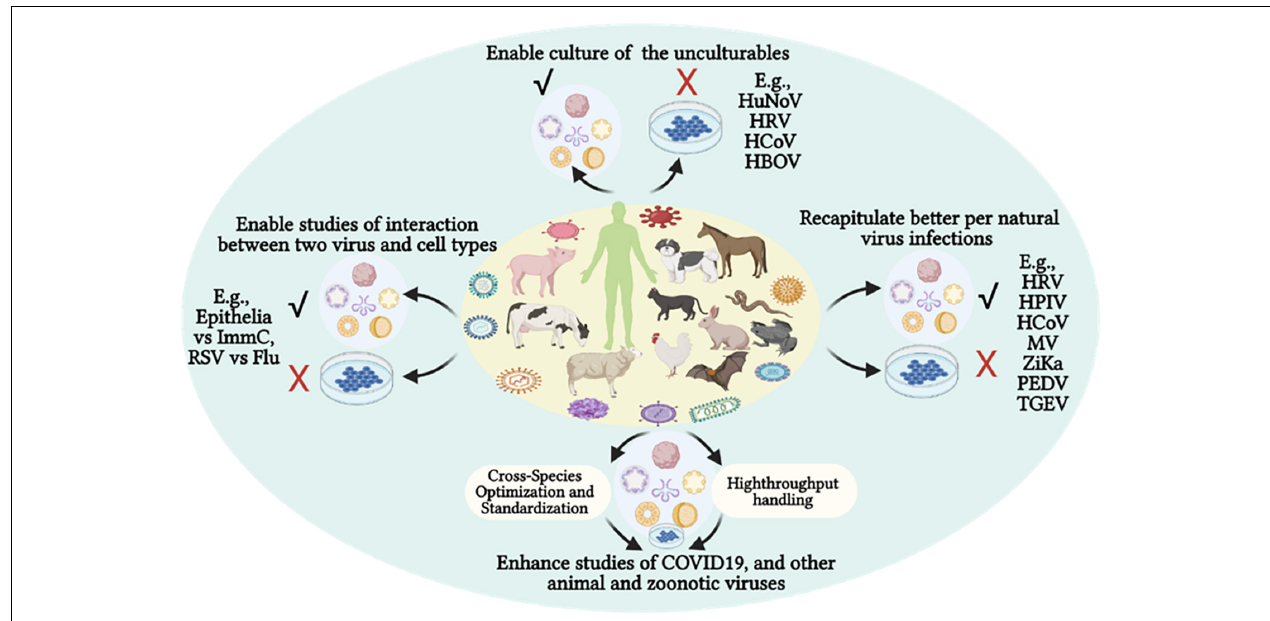
FIGURE 3 | Organoid culture potentiates virological studies, providing a better system to enable recapitulating of the natural viral infections regarding productive √ culture ( ) of previous unculturable viruses using cell lines (X) and mimicking in vivo clinical signs and cell interactions. The advantages of organoid cultures in virological studies have recently been demonstrated using multiple human viruses — particularly in COVID-19 studies — and have shaped prospective cross-species modeling of epizootic or zoonotic viral infections. COVID-19, new coronavirus disease 2019; Flu, influenza virus; HBOV, human bocavirus; HCoV, endemic human respiratory coronaviruses; HPIV, human parainfluenza virus; HuNoV, human norovirus; HRV, human rhinovirus; ImmC, immune cells; MV, measles virus; PEDV, porcine epidemic diarrhea virus; TGEV, porcine transmissible gastroenteritis coronavirus; RSV, respiratory syncytial virus; Zika, Zika virus.